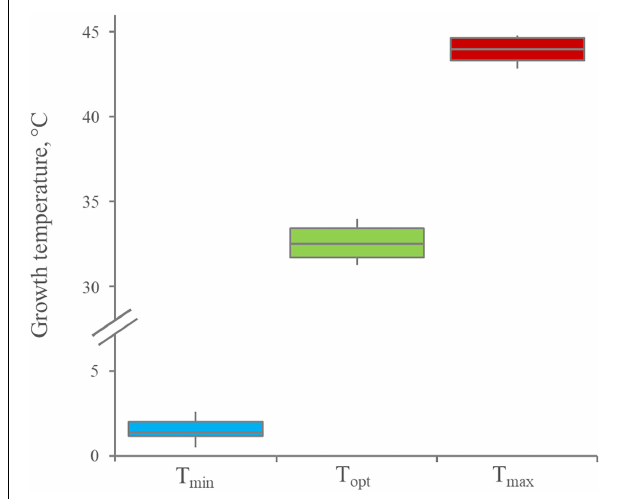
FIGURE 1 | Distribution of minimum, optimum, and maximum growth temperature for 12 Leuconostoc carnosum strains, cultured in MRS broth for 48 h. Boxes indicate the 25th, 50th, and 75th percentiles; whiskers indicate the 10th and 90th